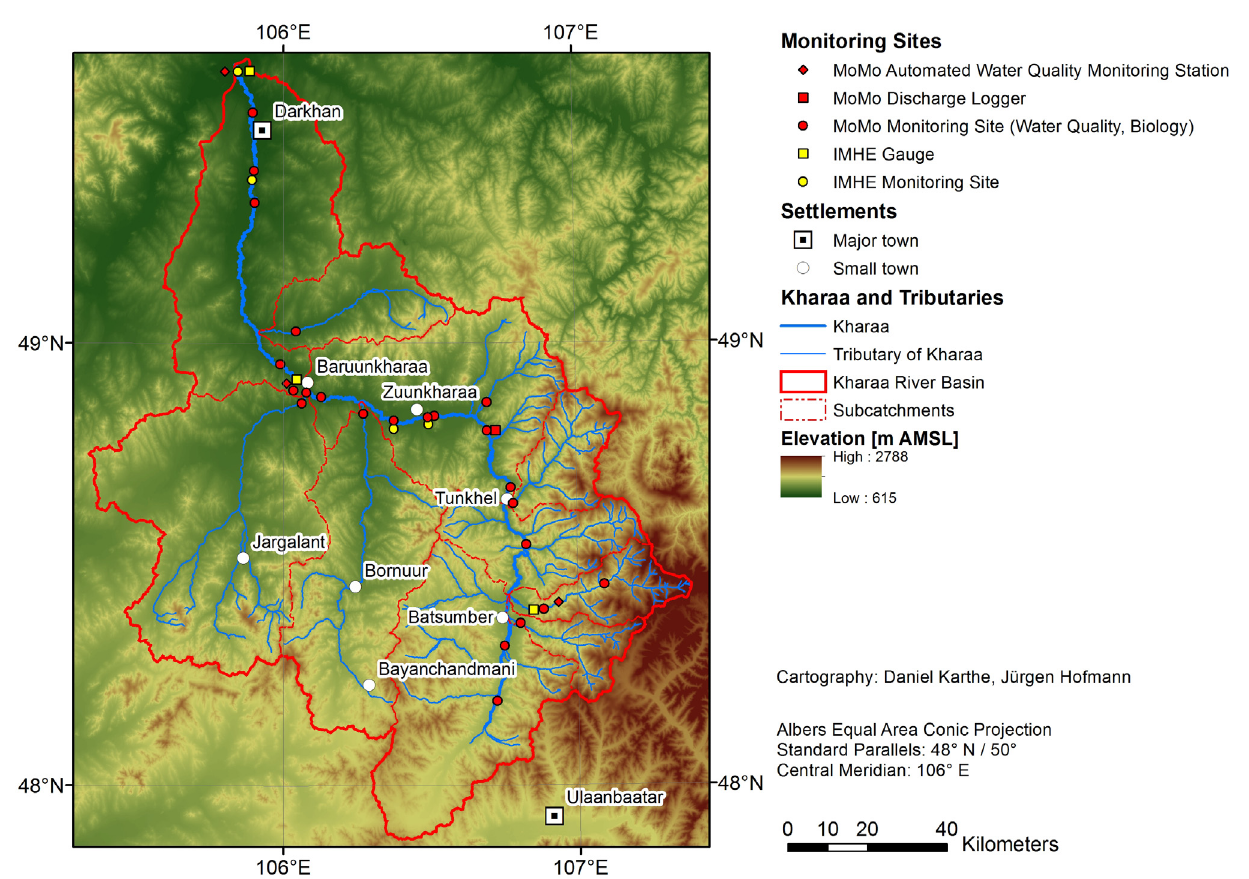
Figure 1. Discharge and water quality monitoring sites by the Central Laboratory for Environment at the Institute of Meteorology, Hydrology and the Environment (IMHE) (yellow) and the Integrated Water Resources Management in Central Asia—Model Region Mongolia (IWRM MoMo) project (red) in the Kharaa River